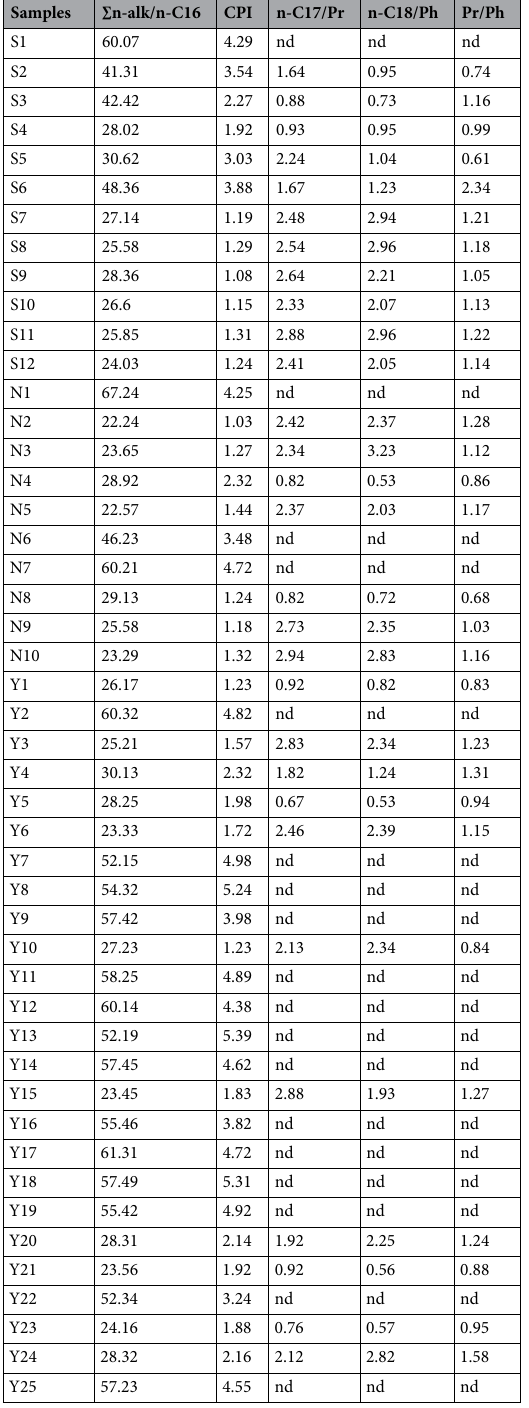
Table 2. The geochemical indices of n-alkanes in different oilfield soils. ∑n-alk/n-C16: Sum of n -alkanes (C8- C40) over to n -alkane (C16); CPI: odd to even carbon preference index from n-C8 to n-C40; C17/Pr: ratio of n-alkane (C17) to pristane; C18/Ph: ratio of n -alkane (C18) to phytane; Pr/Ph: ratio of pristane to phytane; nd: not